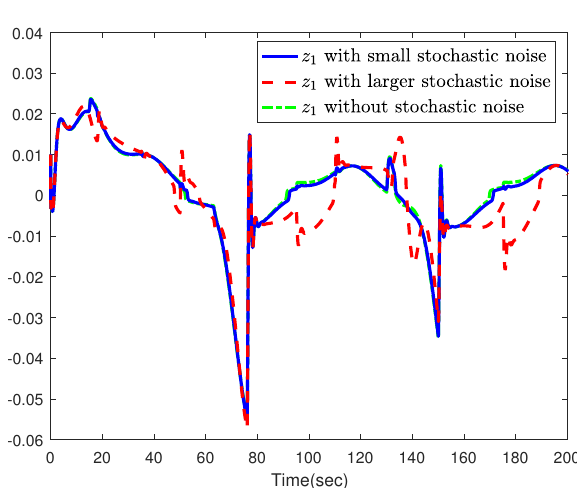
Figure 6. Switching signal.